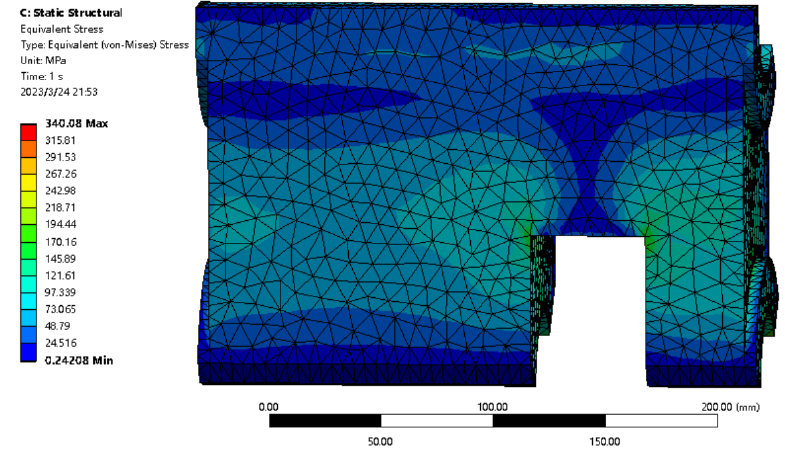
Figure 9. Stress of solid drive rod.